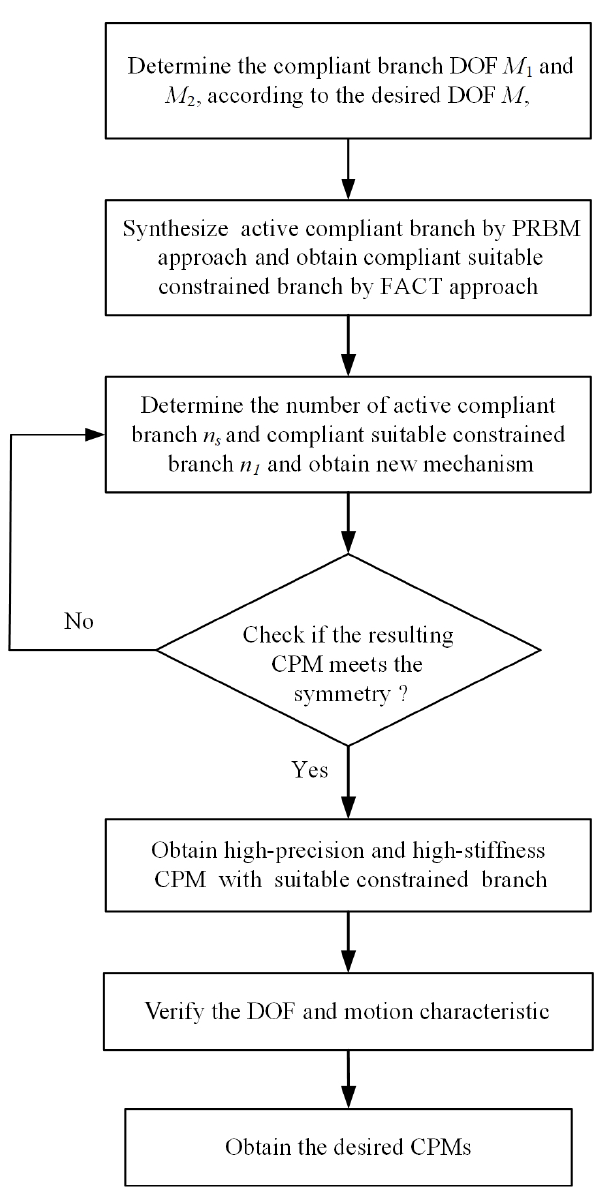
Figure 5. Flow chart for the new approach for type synthesis of the CPM.